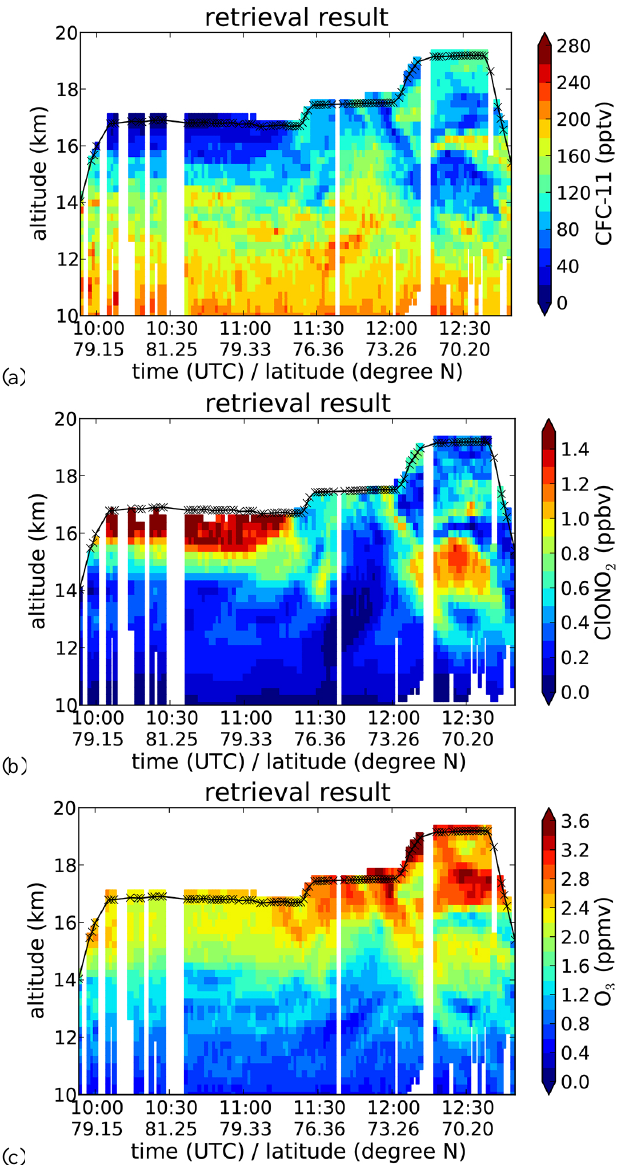
Fig. 3. CRISTA-NF retrieval results for CFC-11, ClONO 2 , and O 3 for RECONCILE flight 11 (2 March 2010). All results with a mea- surement contribution of less than 0.7 are excluded. The solid black line shows the observer altitude and the position (time) of each pro- file is marked by a black cross. Additionally, the abscissa displays the latitude at 12km tangent height. The vertical white stripes show times with insufficient measurements by CRISTA-NF due to strong aircraft movements (e.g. turn at about